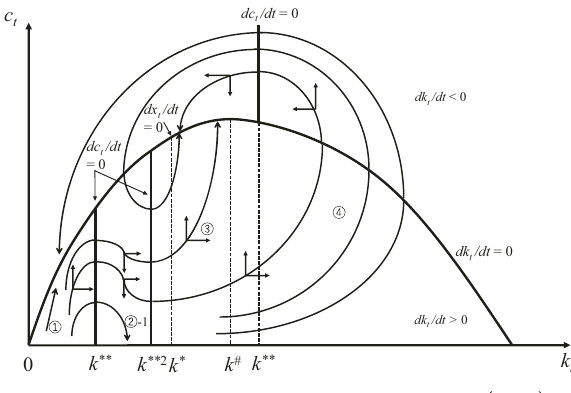
Fig. 3 Decision-making structure over time in the budgetary control model.